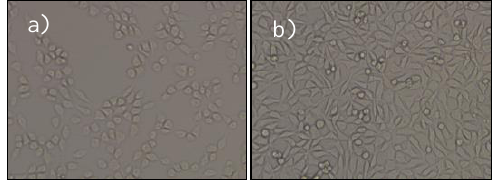
Fig. 10. Sterile closed cell culture container